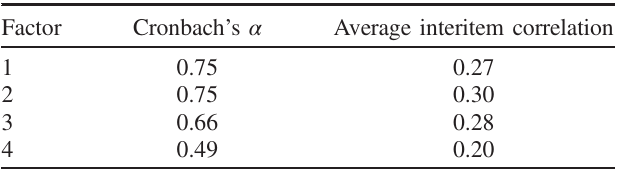
TABLE VII. Cronbach ’ s α and average inter-item correlation for each factor in the 20-item, four-factor